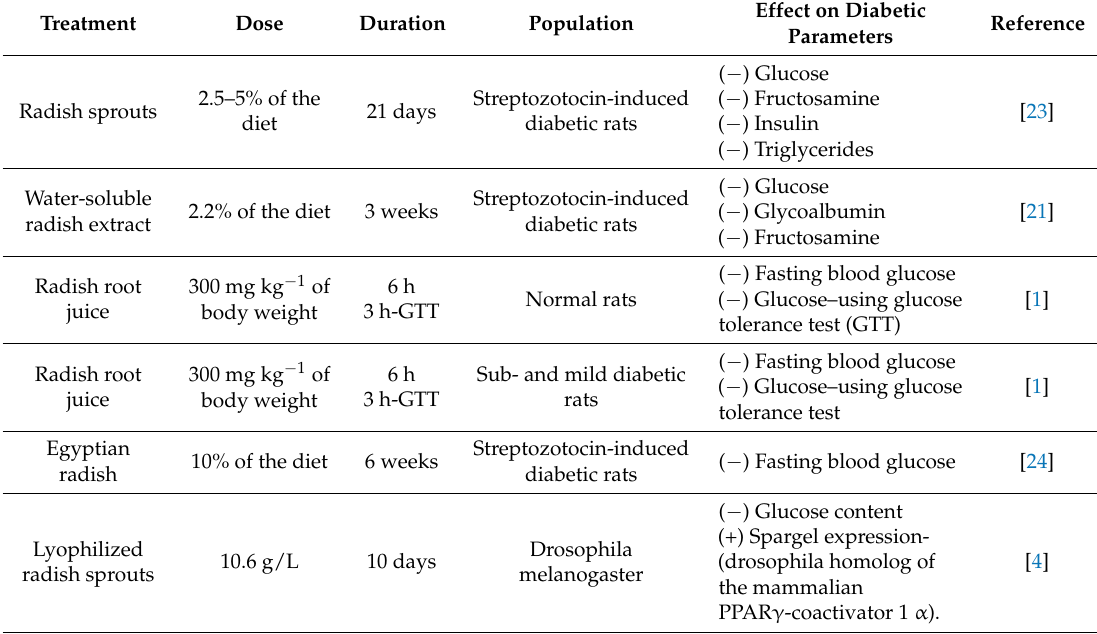
Table 1. A summary of the studies done on radish and its extracts and their reported effects on diabetic